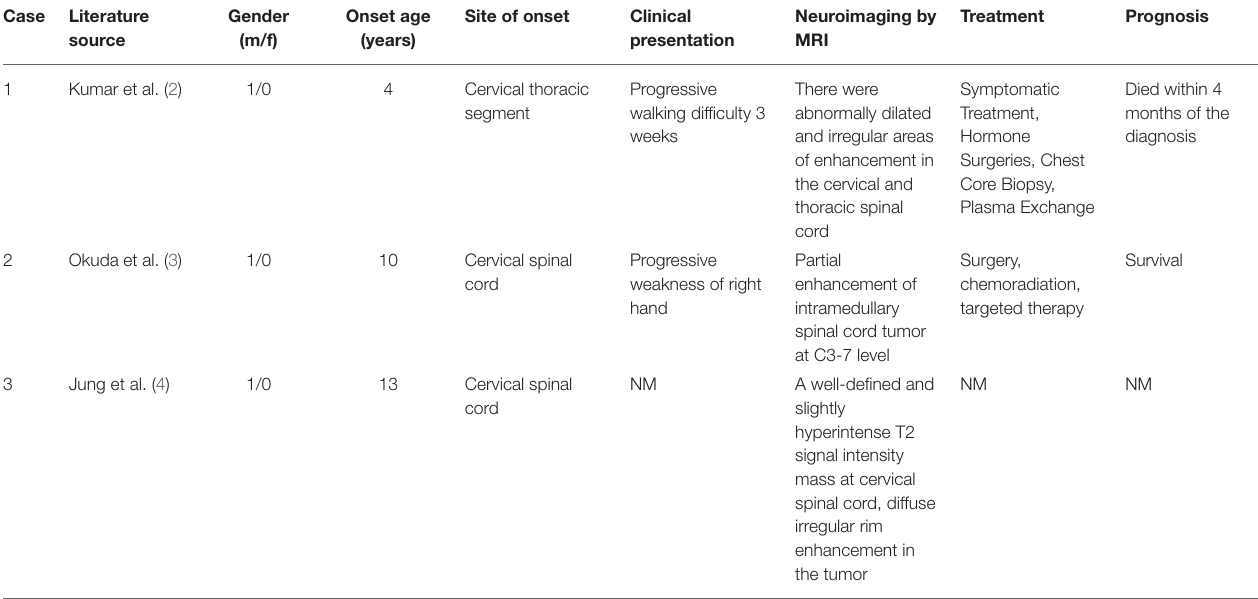
TABLE 2 | Literature